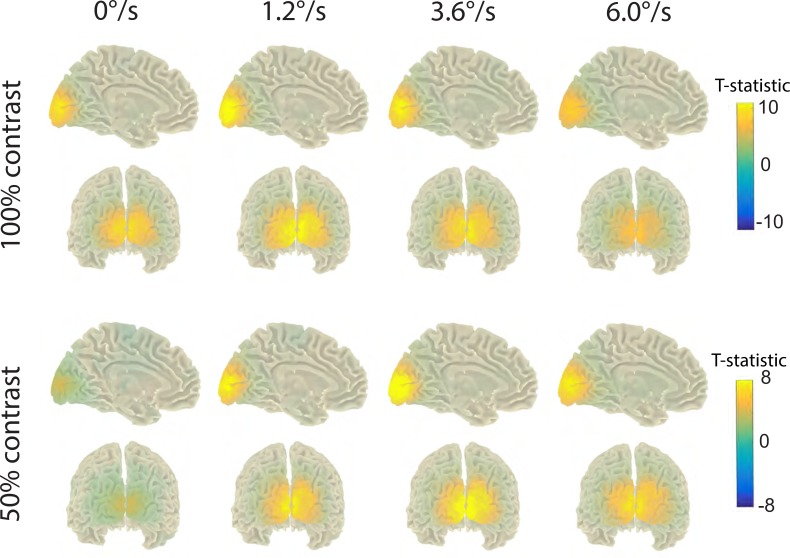
Grand average statistical maps of the cortical GRs to drifting visual gratings.The maps are given for the weighted peak gamma power, separately for the two contrasts and four motion velocities. Positive signs of the t-statistics correspond to stimulation-related increases in gamma power. Note the different scales for the 50% and 100% contrasts and that the magnitude of the GR was affected by both contrast and velocity.